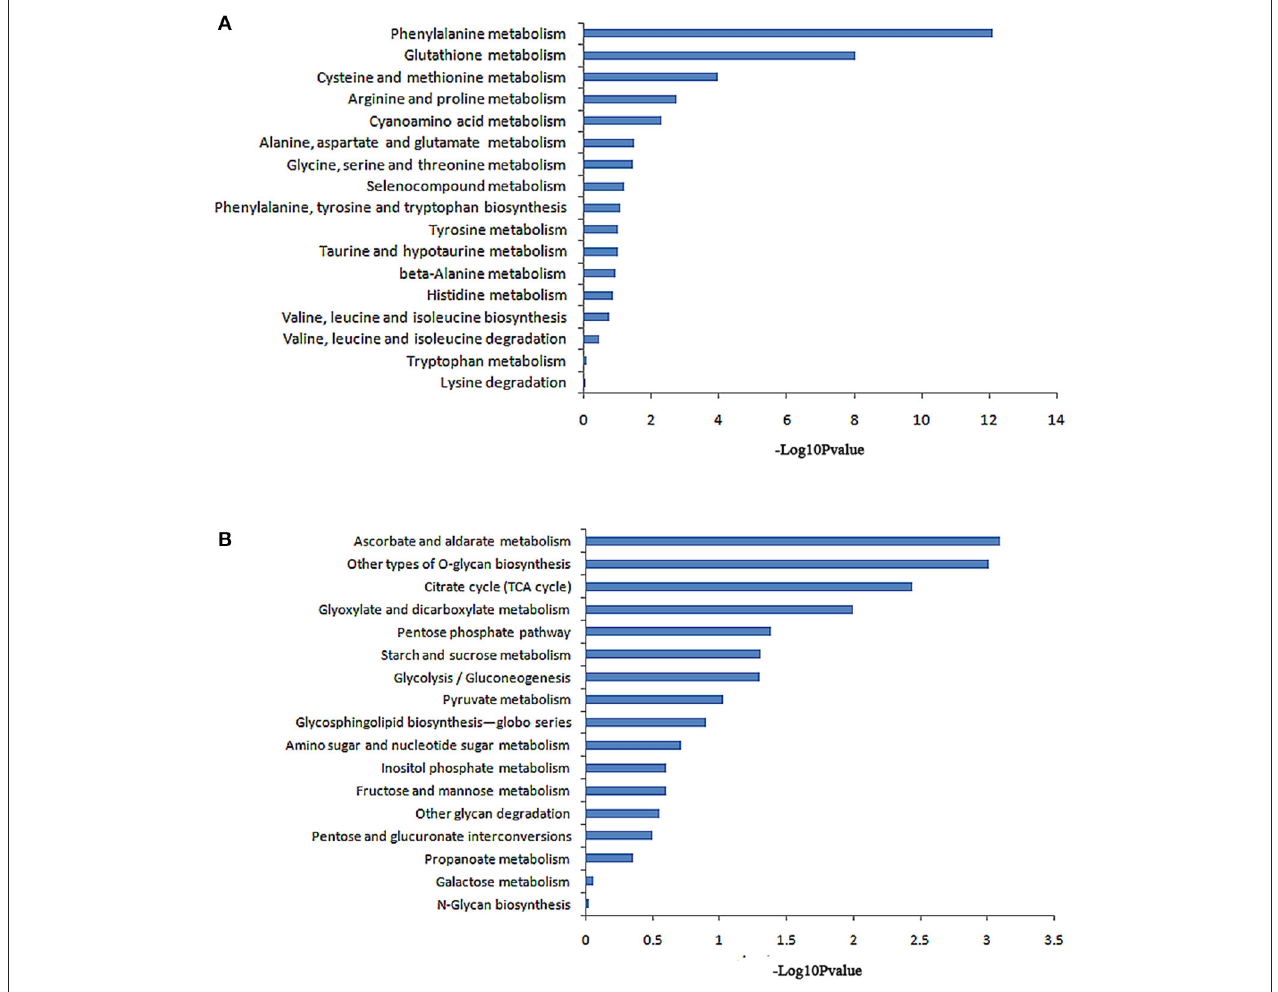
FIGURE 3 | Pathway enrichment analysis of differentially displayed genes. (A) Amino acid metabolic pathway, (B) Carbohydrate metabolic